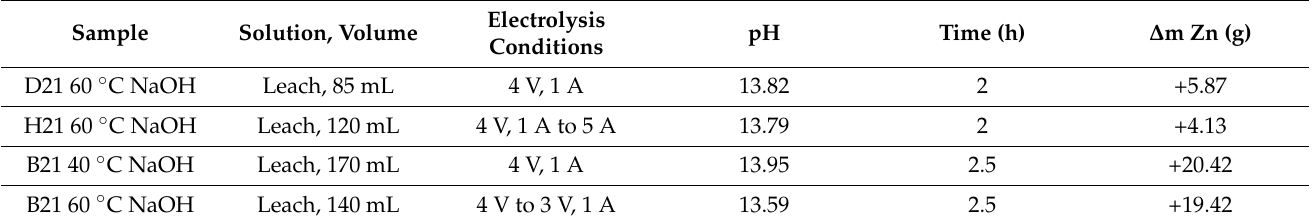
Table 16. The conditions for the electrolysis of the leaches from three suppliers, the cathode—a stainless plate; the anode—a nickel plate.